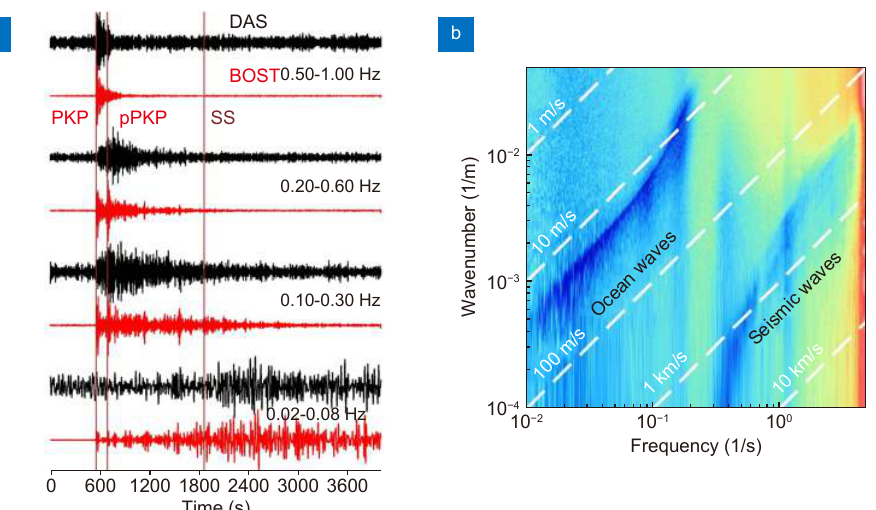
Fig. 5 | ( a ) Stacked DAS beam trace (black) filtered to various bands between 0.02 and 1 Hz compared with amplitude-normalized particle velo- city from a broadband seismometer rotated into the mean azimuth of the DAS array (red). ( b ) Separation of ocean and seismic waves in the first quadrant of the logarithmic space of the Φ-OTDR signal frequency-wave number domain. Figures reproduced from ref. 101 , under a Creative Com- mons Attribution 4.0 International